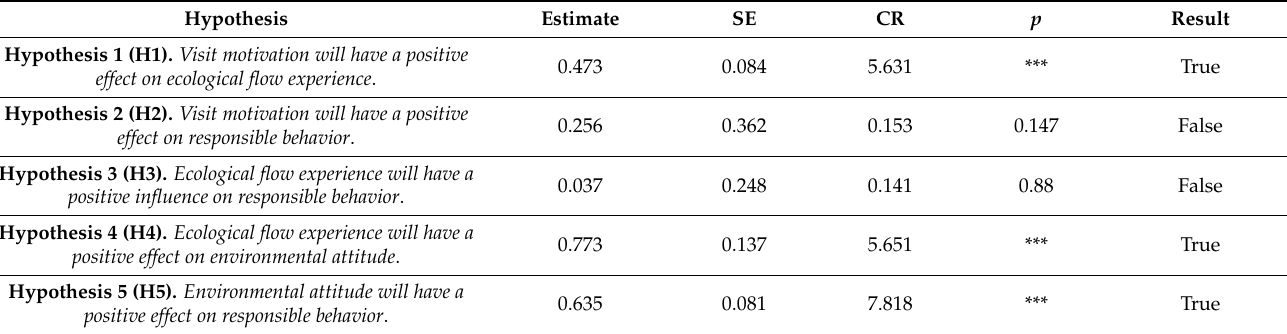
Table 7. Second-order factor model normalization